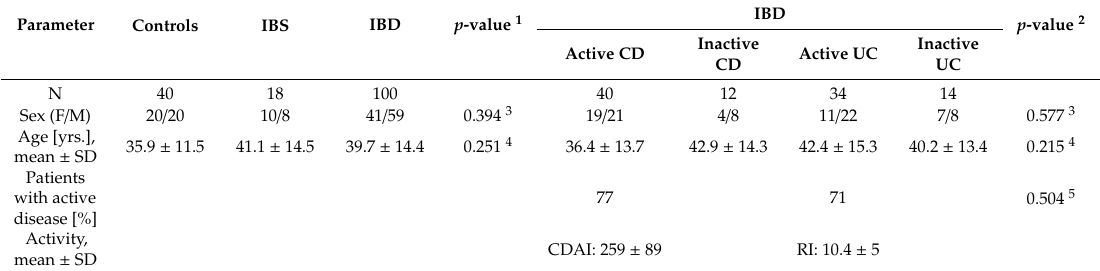
Table 6. Demographic characteristics of study population: metabolomic